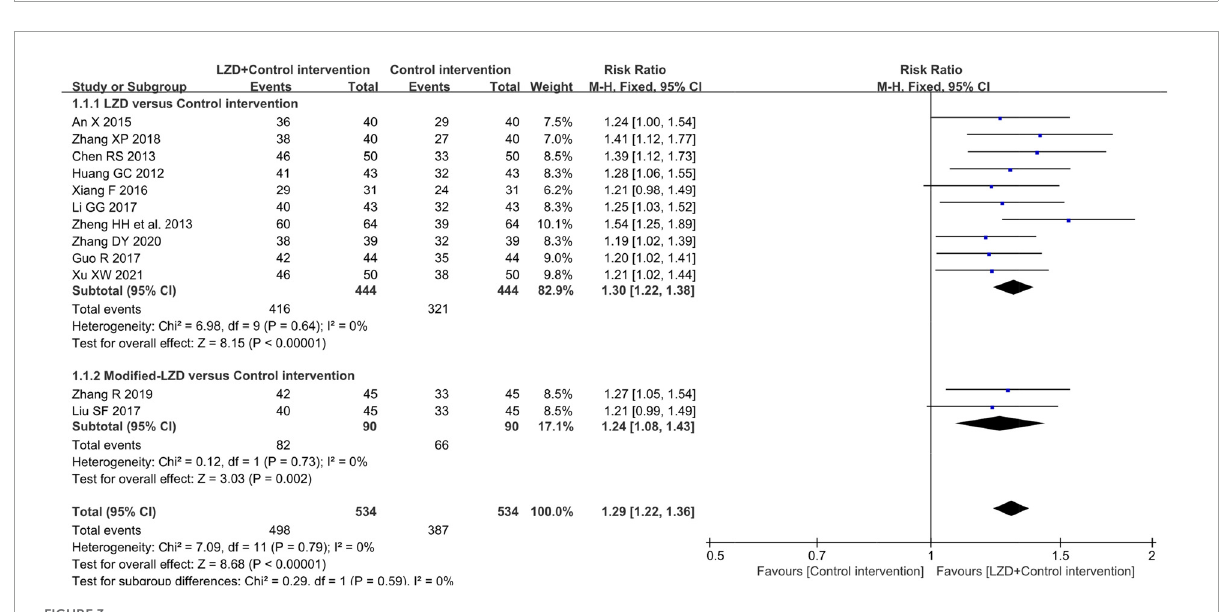
FIGURE3 Forest plot for the comparison of clinical effectiveness between the intervention group and control